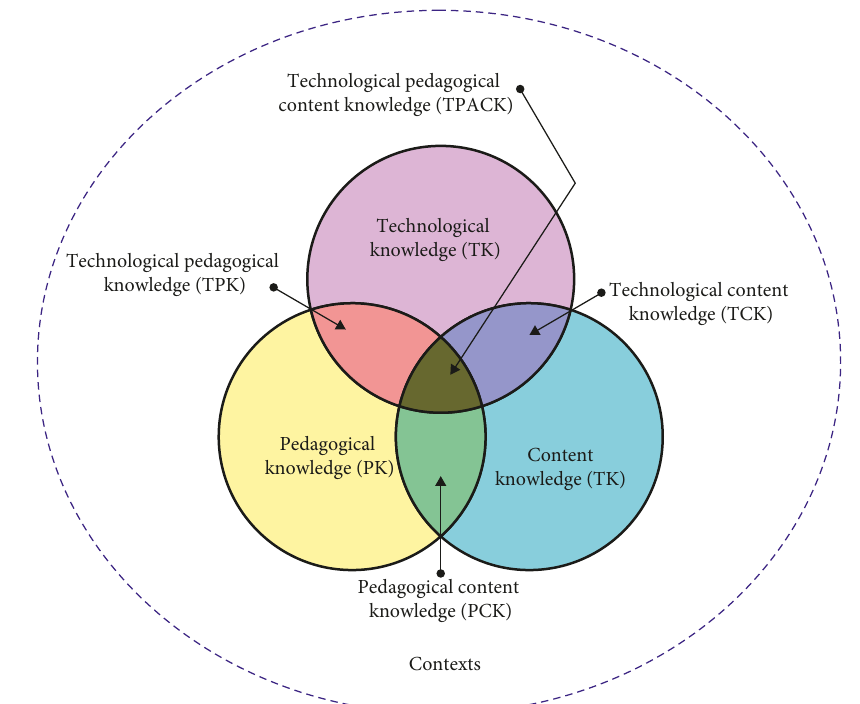
Figure 7: The components of the TPACK